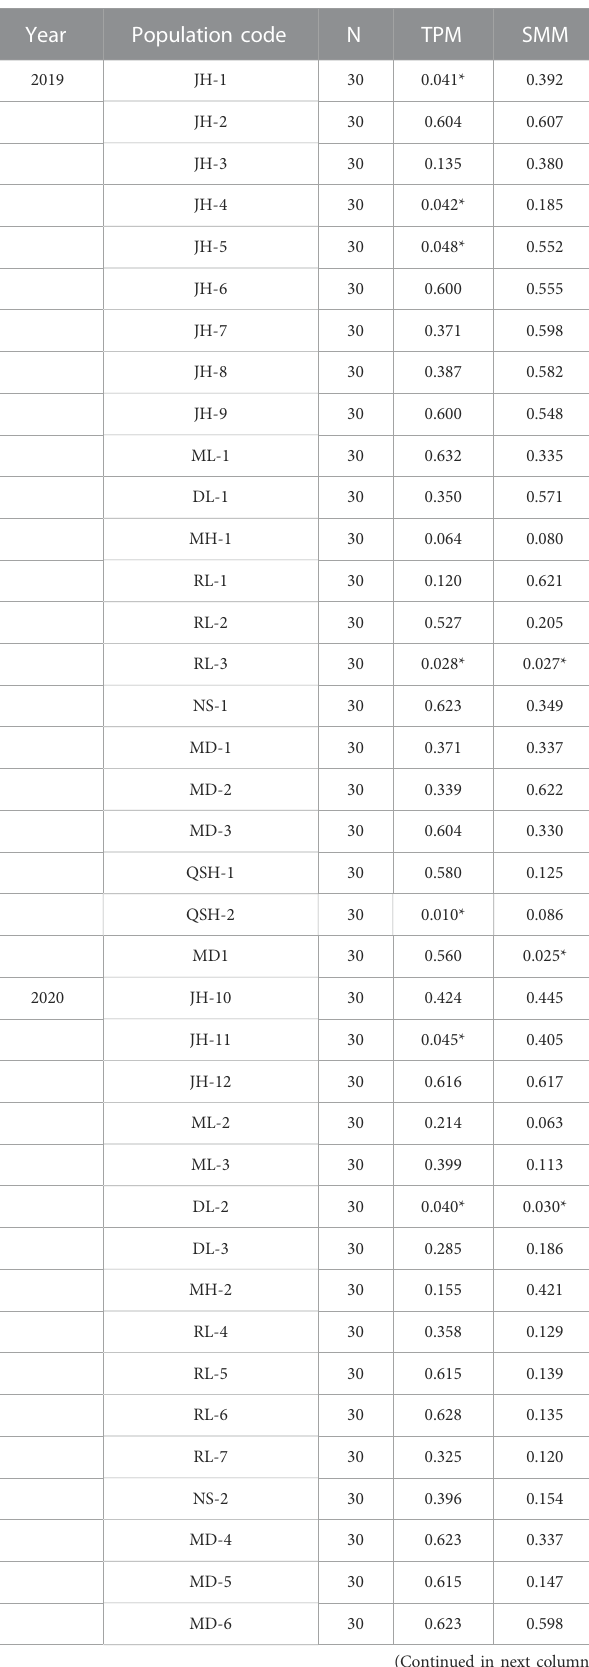
TABLE 5 Probability value for bottlenecks in 2019 and 2020. TABLE 5 ( Continued ) Probability value for bottlenecks in 2019 and